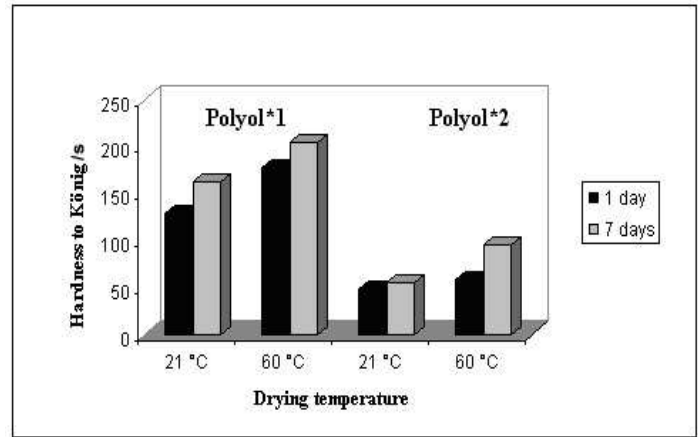
Figure 4 . Dependence of the hardness development on drying conditions (applied on a glass plate, 30 µm dry film